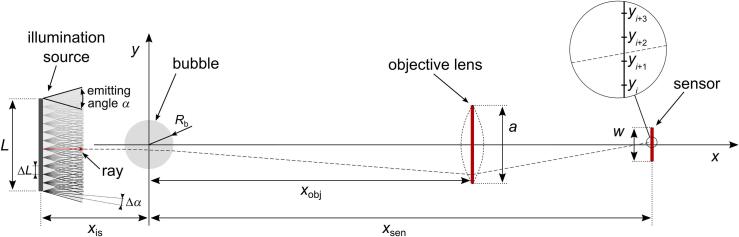
Numerical modeling of illumination in bubble imaging.